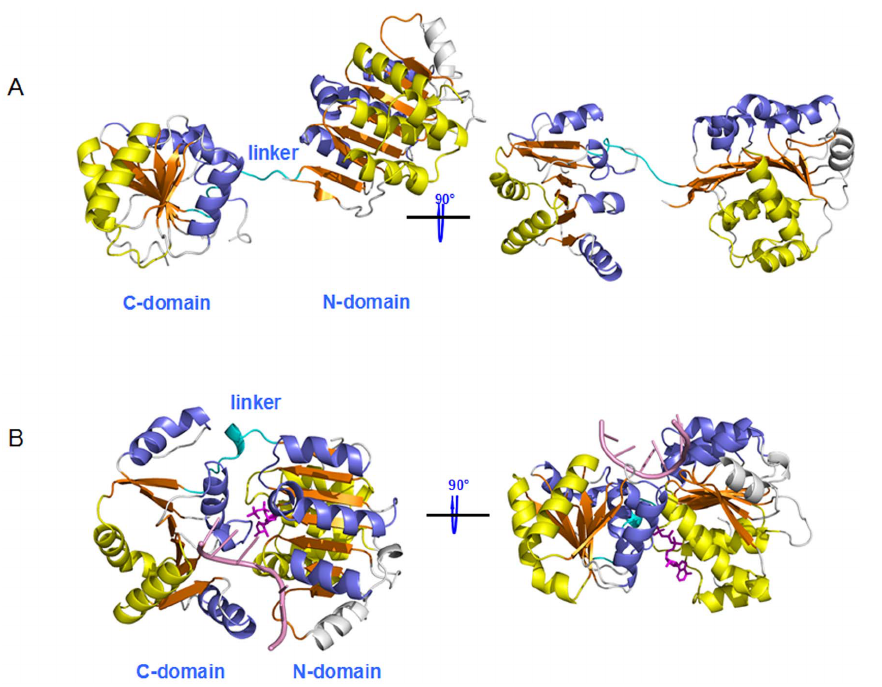
Figure 3. The structures of the open and closed states. MD-simulated overall structures for (A) the open eIF4A state and (B) the closed eIF4A state bound by ATP (colored in magenta) and RNA (colored in pink), the linker in which is colored in cyan.